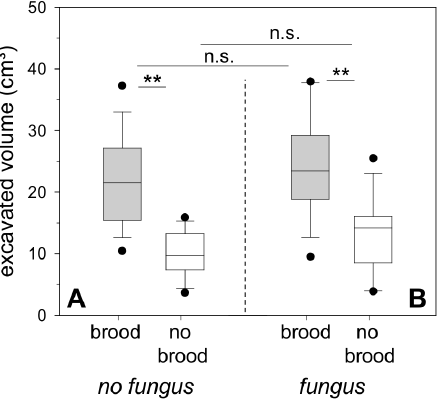
Figure 4. Digging activity (excavated volume) at nest sites with and without brood after 24 h (median ± 25–75% percentiles, min max values and outliers, n = 15). **p , 0.01; n.s. = not significant, p . 0.05 (a) Experiment 5: Digging activity with brood only